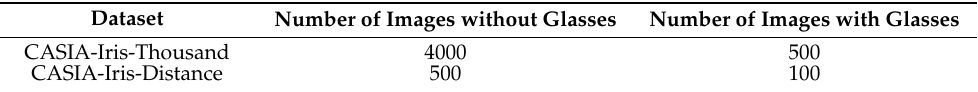
Table 2. Dataset Composition. Table 3. Comparison results of iris localization at a short distance.